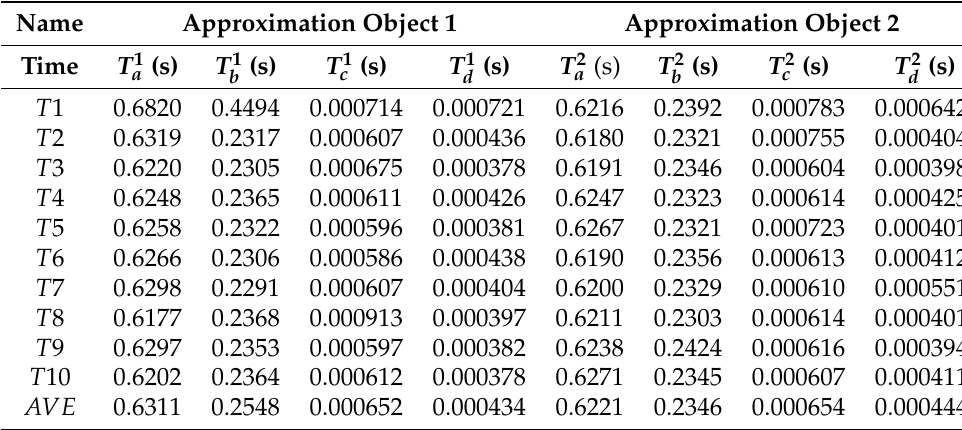
Table 3. The time required for different approximating